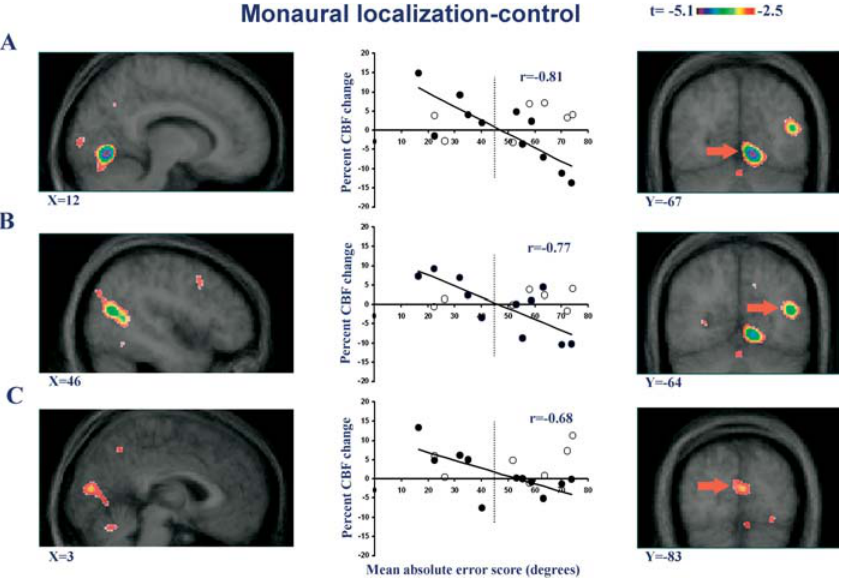
Figure 5. Correlational Analysis for Monaural Sound Localization in Blind Persons These data show the correlational analysis between performance (mean absolute error) in pointing task to monaurally presented sounds and CBF in a group of blind subjects. The two columns of brain images (left image series, sagittal sections; right image series, coronal sections) illustrate the statistical parametric map of the correlation, which is maximal in the ventral extrastriate cortex (A) but also significant in dorsal extrastriate (B) and striate (C) cortices. The red arrows in the coronal slices indicate the focus selected for the respective sagittal slices. The scattergram shows the individual values extracted from each of these regions; closed circles indicate blind subjects; open circles indicate SIG. The dotted vertical line represents the cutoff in performance for the a priori classification of blind subjects into those with low error rates (EBSP) and those who do not show the enhancement (EBNP). X and Y coordinates refer to standardized stereotaxic space. DOI: